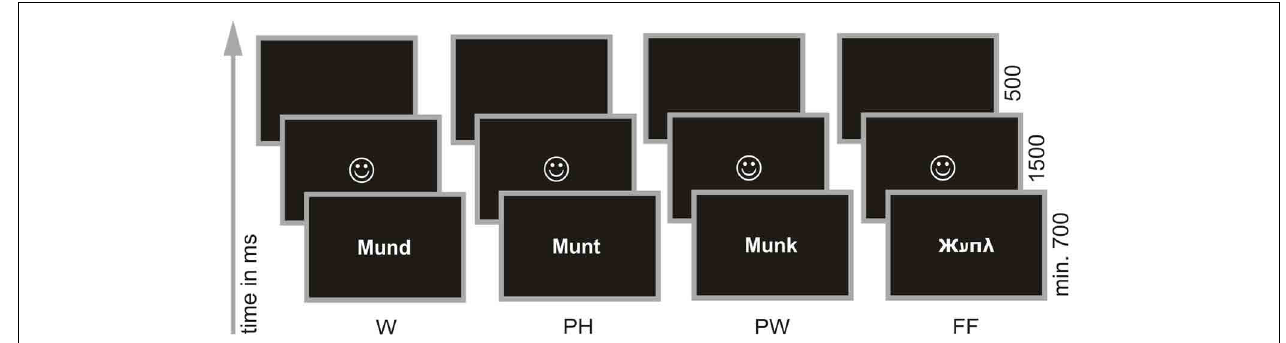
individually in white on black background in the center of a 17 inch screen. Participants were instructed to decide via button press whether a presented stimulus sounded like a real word or not. Figure taken from Hasko et al. (2013).